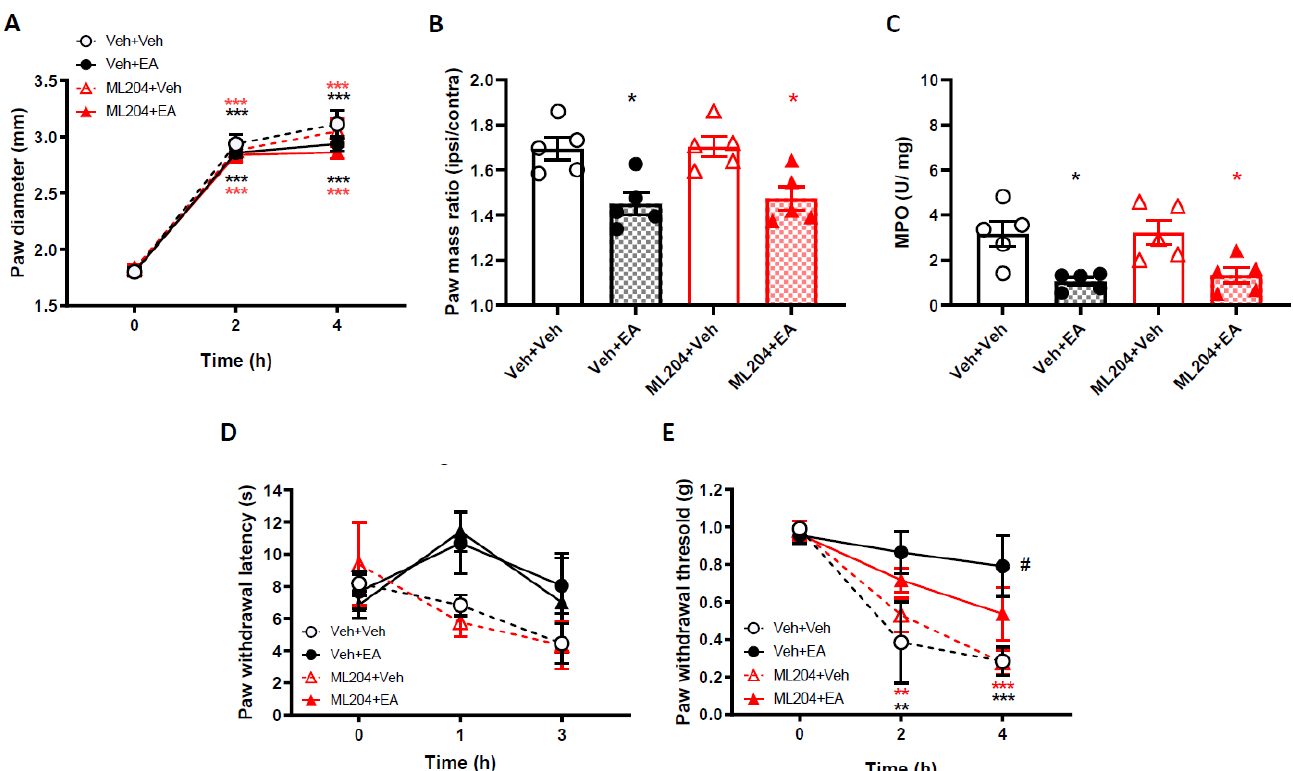
Figure 5. ML204 fails to revert EA effect on carrageenan-induced paw oedema and mechanical and thermal hyperalgesia. ( A ) Time-course of paw oedema measured by callipers and ( B ) ipsilateral/contralateral paw mass ratio 4 h following induction of paw oedema by 2% Carrageenan. Data are mean ± S.E.M, n = 5. * p < 0.05, *** p < 0.001 versus baseline, versus vehicle, Two-way ANOVA, post hoc Tukey test. ( C ) Myeloperoxidase (MPO) levels in paw exudates, 4 h after the induction of paw inflammation. Data are mean ± S.E.M, n = 5. * p < 0.05 versus vehicle, Unpaired t -test. ( D ) Thermal and ( E ) mechanical paw withdrawal thresholds measured at baseline and at 1 and 3 or 2 and 4 h, respectively, after intra-plantar injections of carrageenan. ** p < 0.01, *** p < 0.001 versus baseline, # p < 0.05, versus vehicle, Two-way RM ANOVA, post hoc Tukey test. Data are mean ± S.E.M, n = 5.